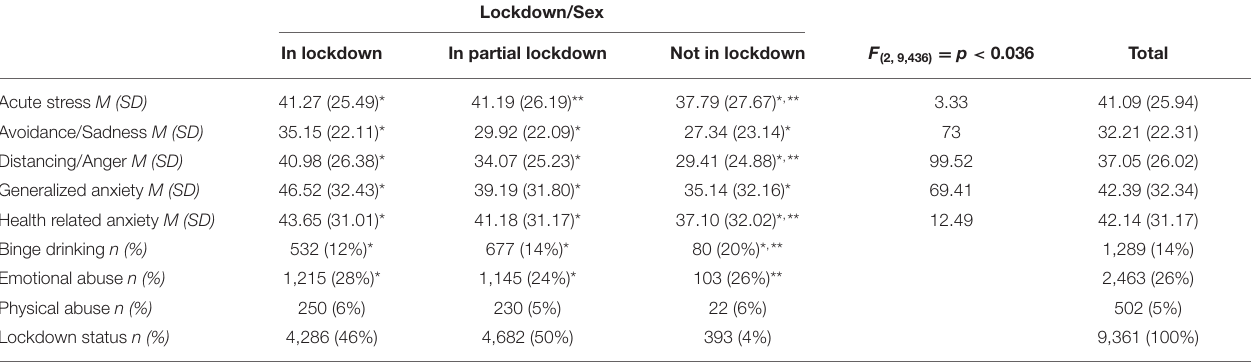
TABLE 2 | Number of respondents by lockdown status during the COVID-19 pandemic and their clinical characteristics.